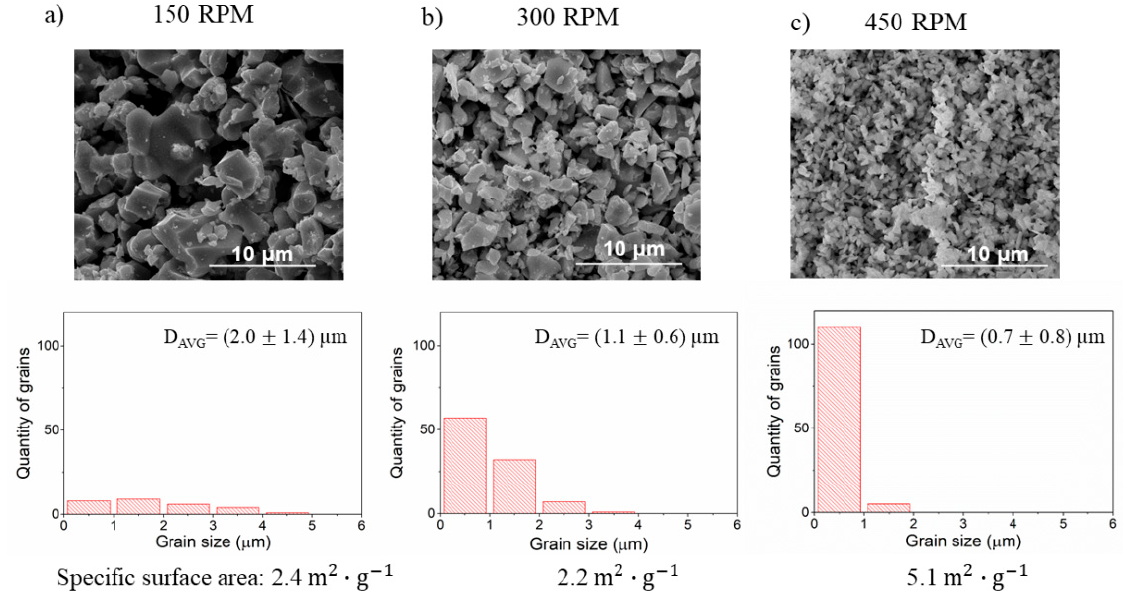
Figure 11. The SEM images, grain size analysis, and specific surface area of the BLCF powders milled with angular velocity ( a ) 150 RPM, ( b ) 300 RPM, and ( c ) 450 RPM.